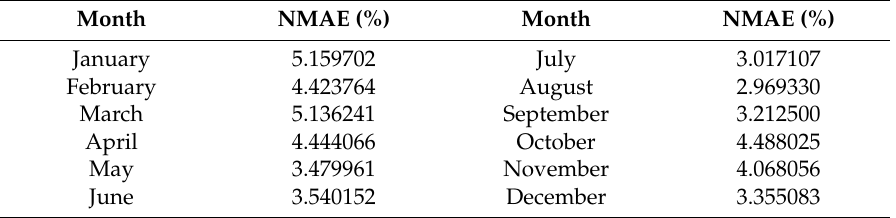
Table 4. The normalized mean absolute error (NMAE) for each month of forecasting in 2016.